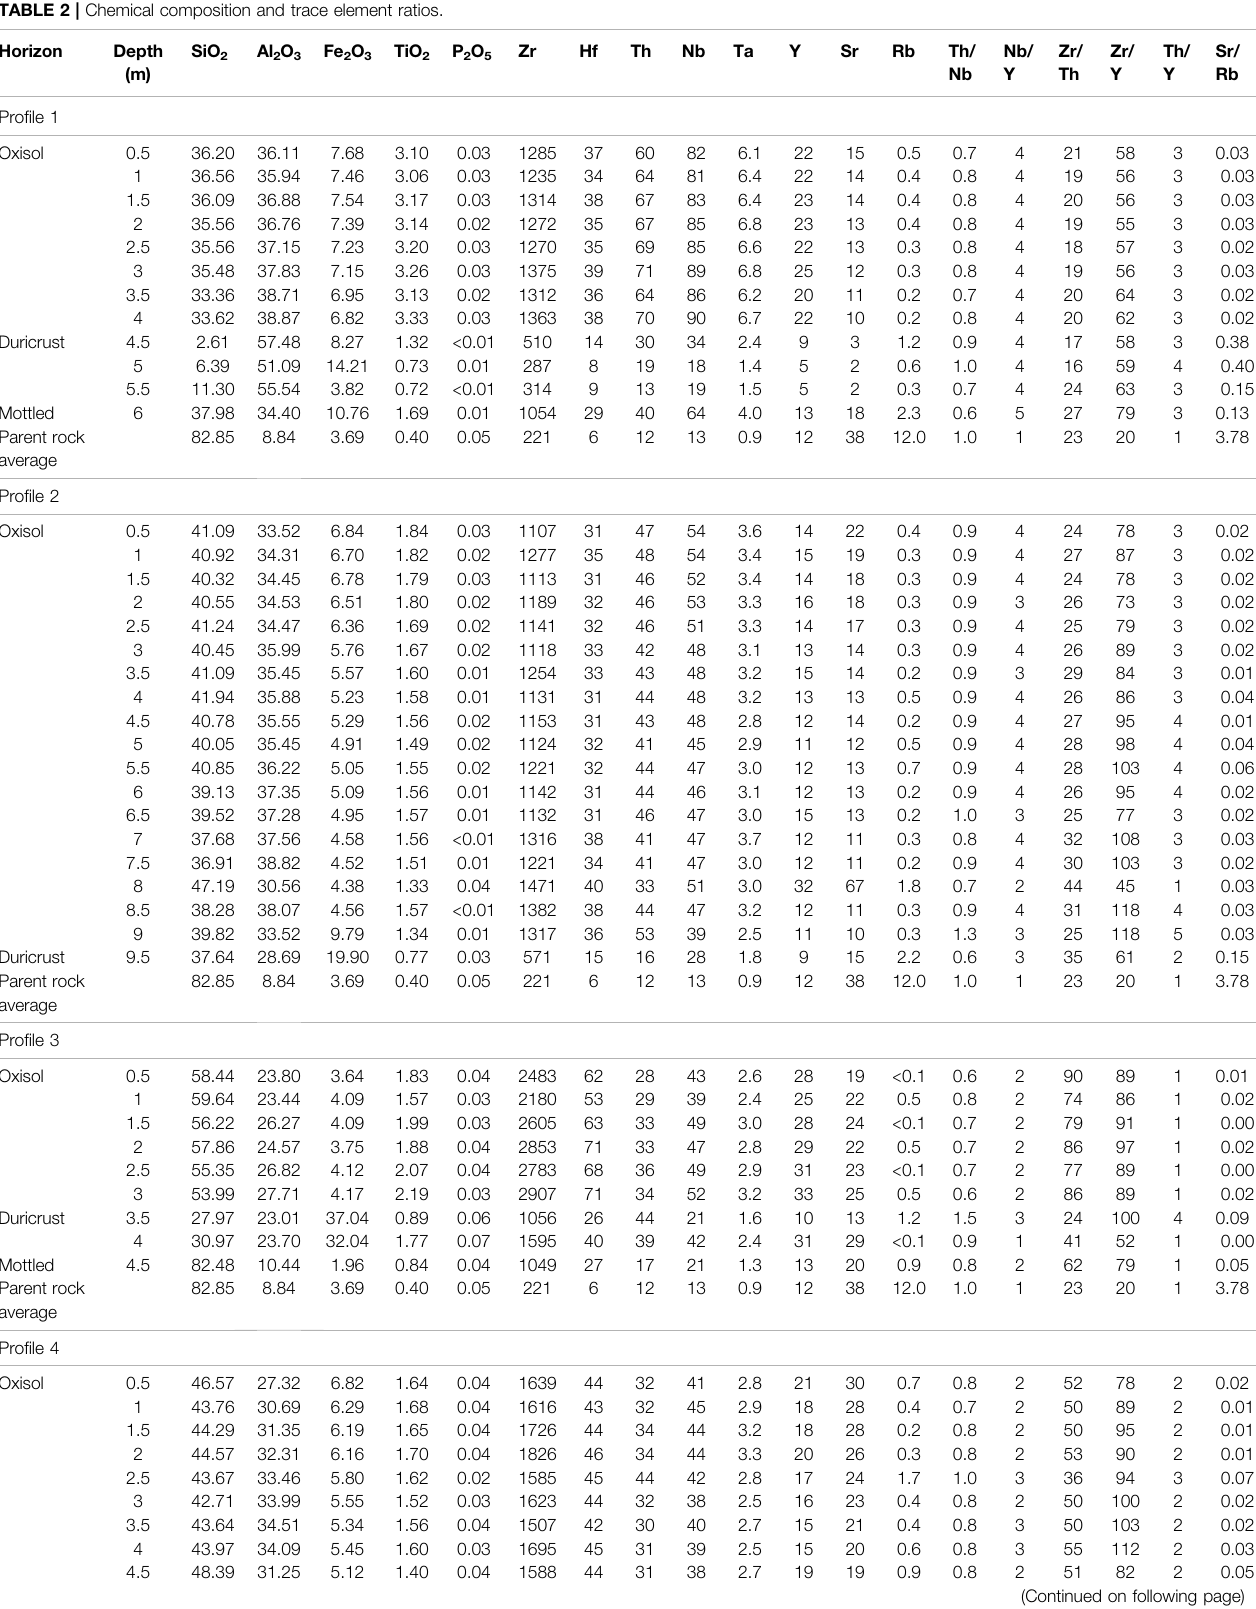
TABLE 2 | Chemical composition and trace element ratios.